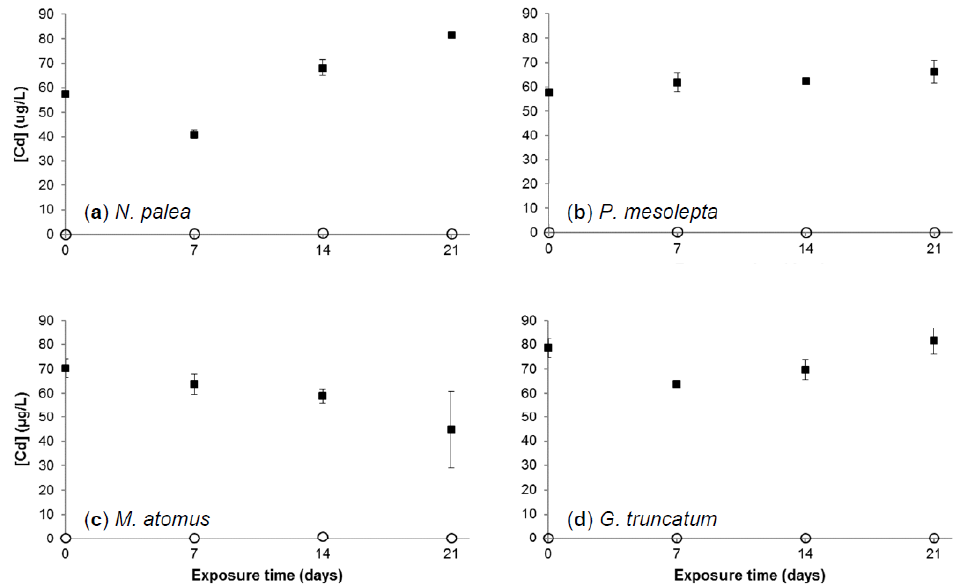
Figure 3. Cadmium concentrations in growth medium ( µ g Cd / L ± standard error, n = 3) for each exposure time for the control and the Cd treatment (Cd 100 ) in ( a ) N. palea , ( b ) P. mesolepta , ( c ) M. atomus , and ( d ) G. truncatum cultures. White circles represent the control and black squares represent Cd treatment (Cd 100 ). Detection and quantification limits were 0.06 and 0.35 µ g Cd / L, respectively. Nominal concentrations were 0 and 100 µ g Cd / L for the control and Cd 100 .